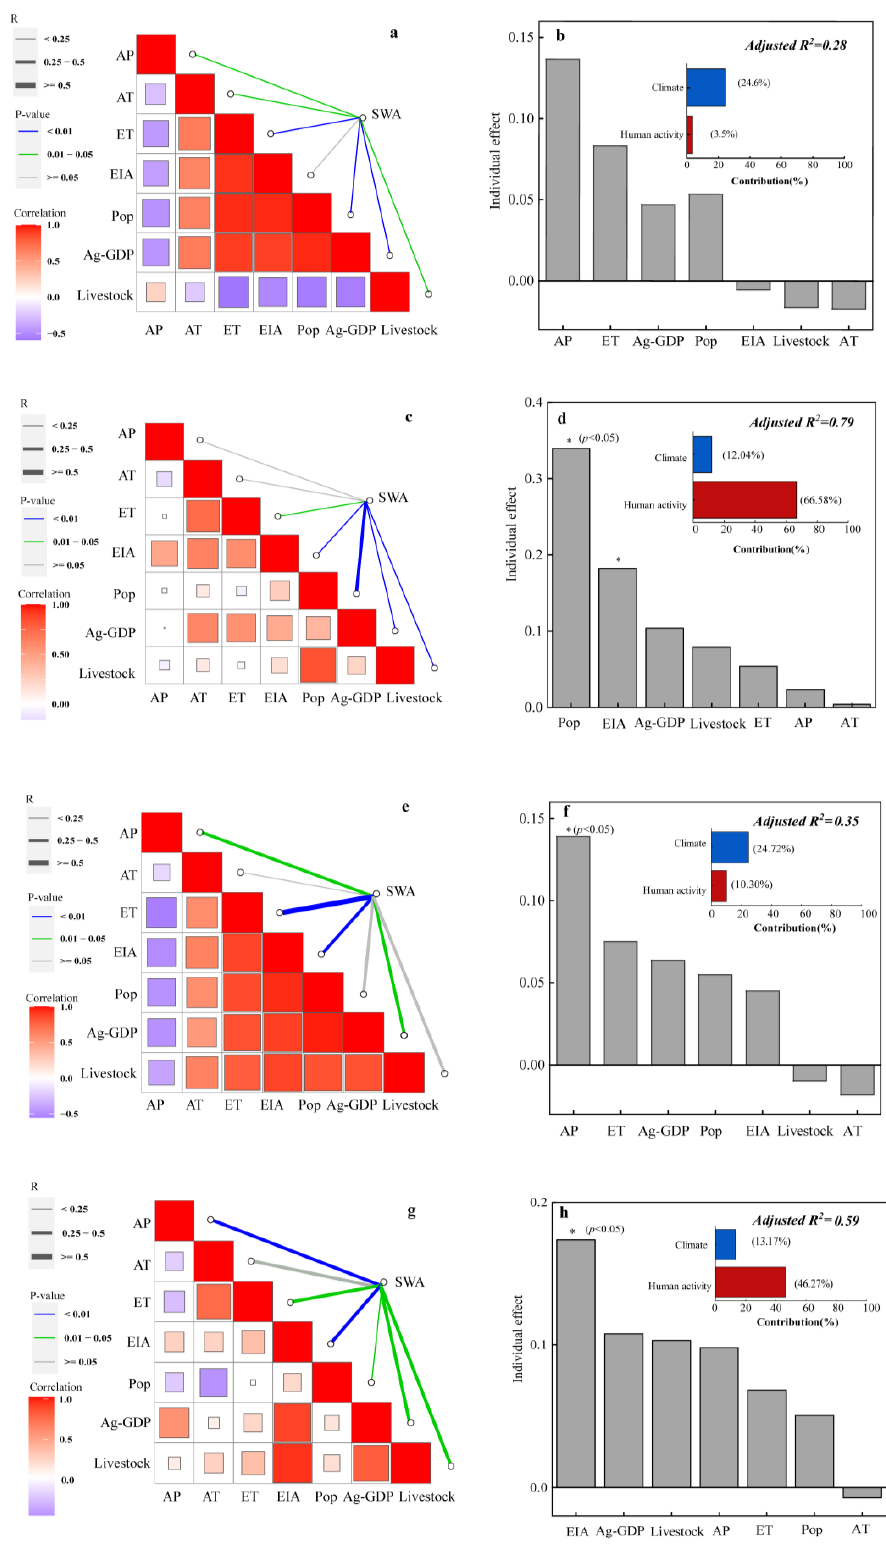
Figure 9. Correlation analysis ( a , c , e , g ) and hierarchical partitioning analysis ( b , d , f , h ) between driving factors and SWA: ( a – d ) the pre-change period and the post-change period in ADR, respectively; ( e – h ) the pre-change period and post-change period in AHDR, respectively. The inserted displays in the right-hand graphs show the relative contribution rate of climate and human activity to